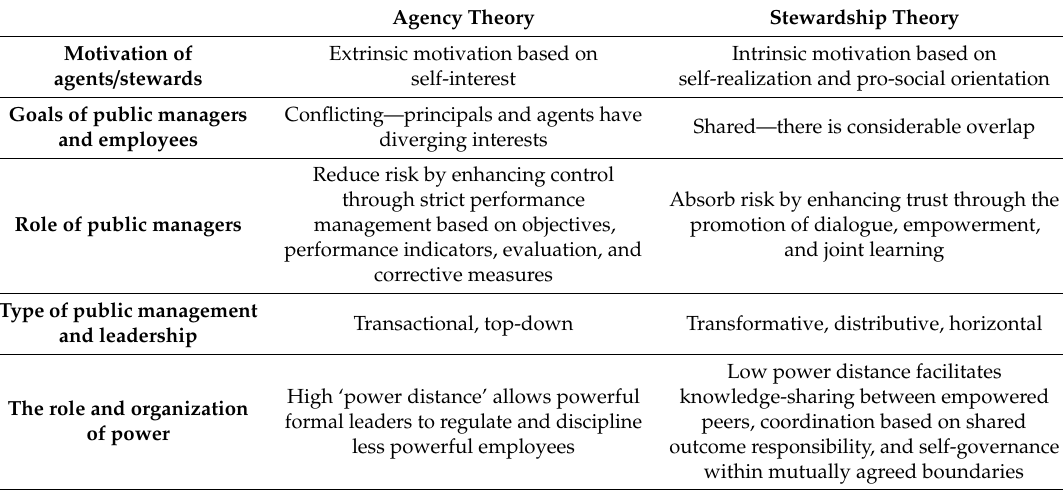
Table 1. Comparison of agency and stewardship theory (adapted from Schillemans (2008) and inspired by Hernandez